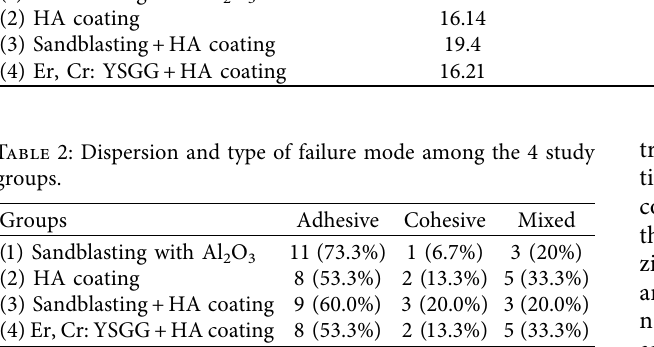
Table 1: Central dispersion indices of μ SBS of resin cement on zirconia surface in diferent preparation groups. Groups